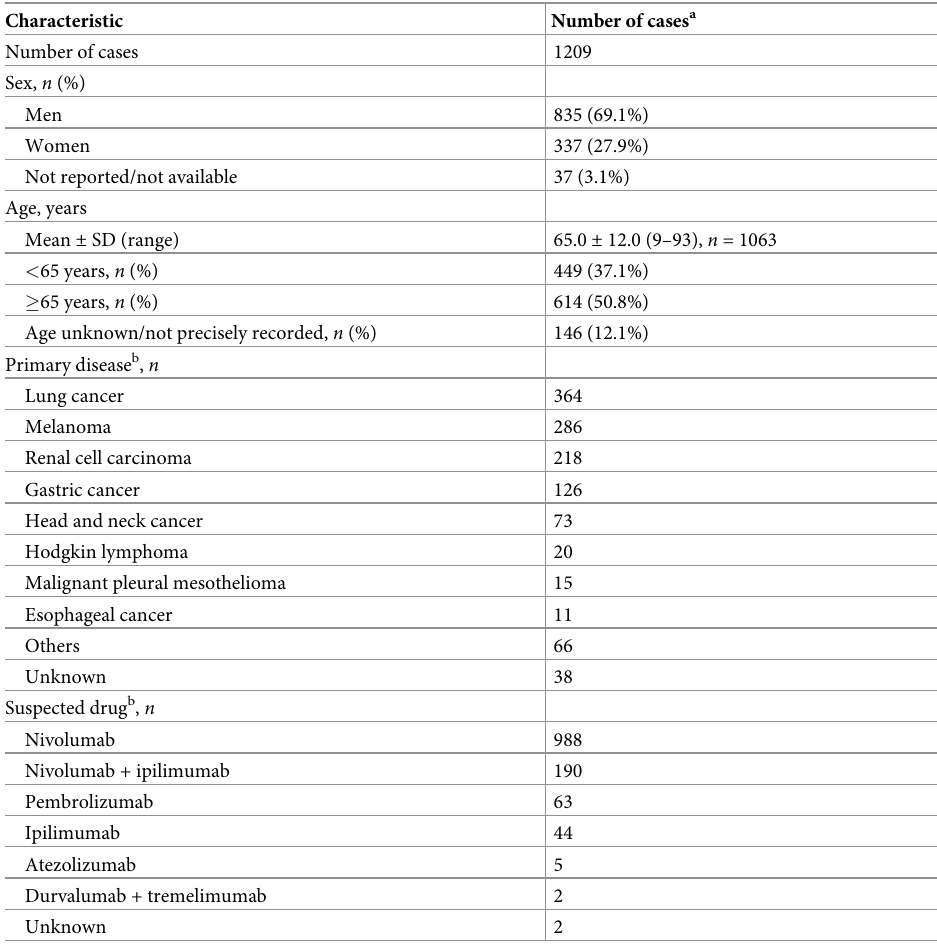
Table 2. Overview of the